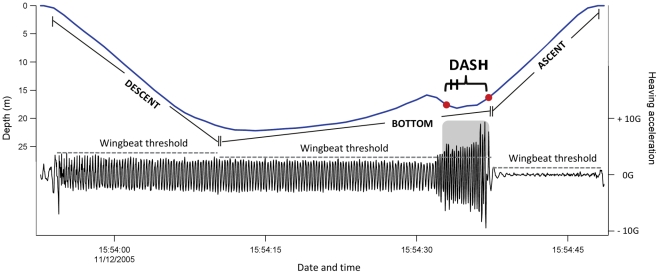
Example of a little penguin foraging dive and the heaving acceleration used to analyse wing beat amplitude and frequency.Upper thresholds were defined for the regular wing beat amplitude of the descent, bottom and ascent phase, being highest during descent and lowest during ascent. Prey pursuits (dashes) were considered when the wing beat amplitude was greater than the threshold of the respective dive phase for more than three consecutive wing beats as shown by the dash example.